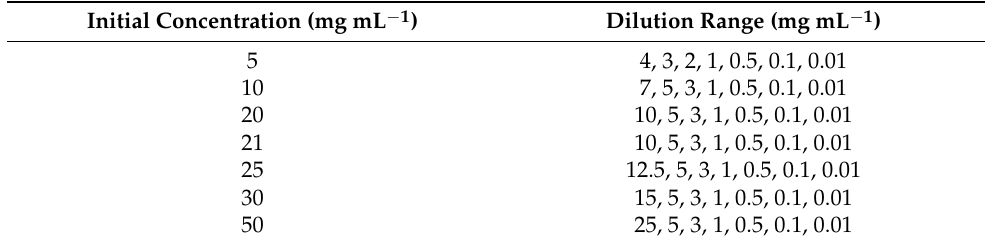
Table 1. The different preparations of dilutions of the 16